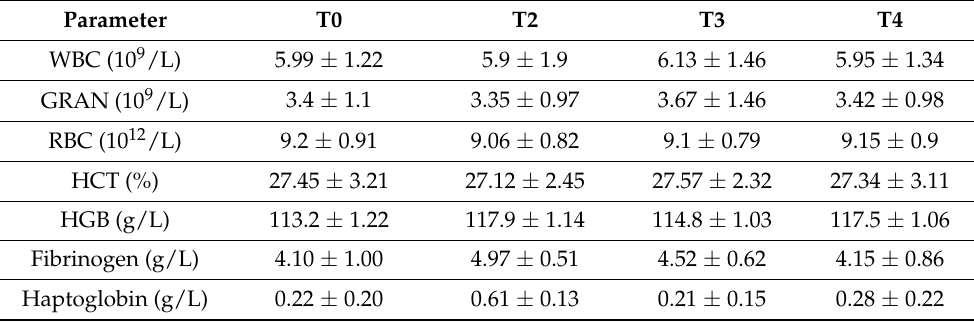
Table 1. Mean hematological and APP parameters ( ± SE) in sheep ( n = 8) before (T0), after 24 h (T2), after 4 months (T3) and after 10 months (T4)